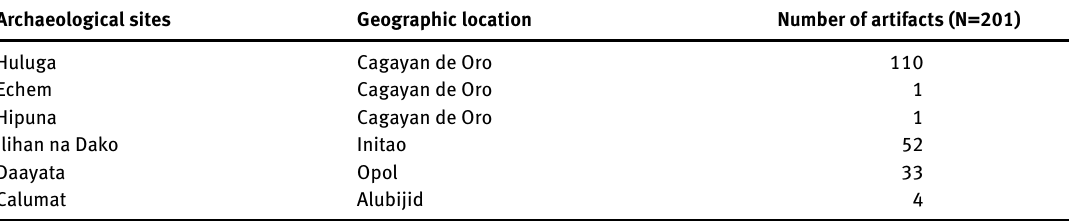
Table 1. Obsidian recovered in different archaeological sites in Northern Mindanao.